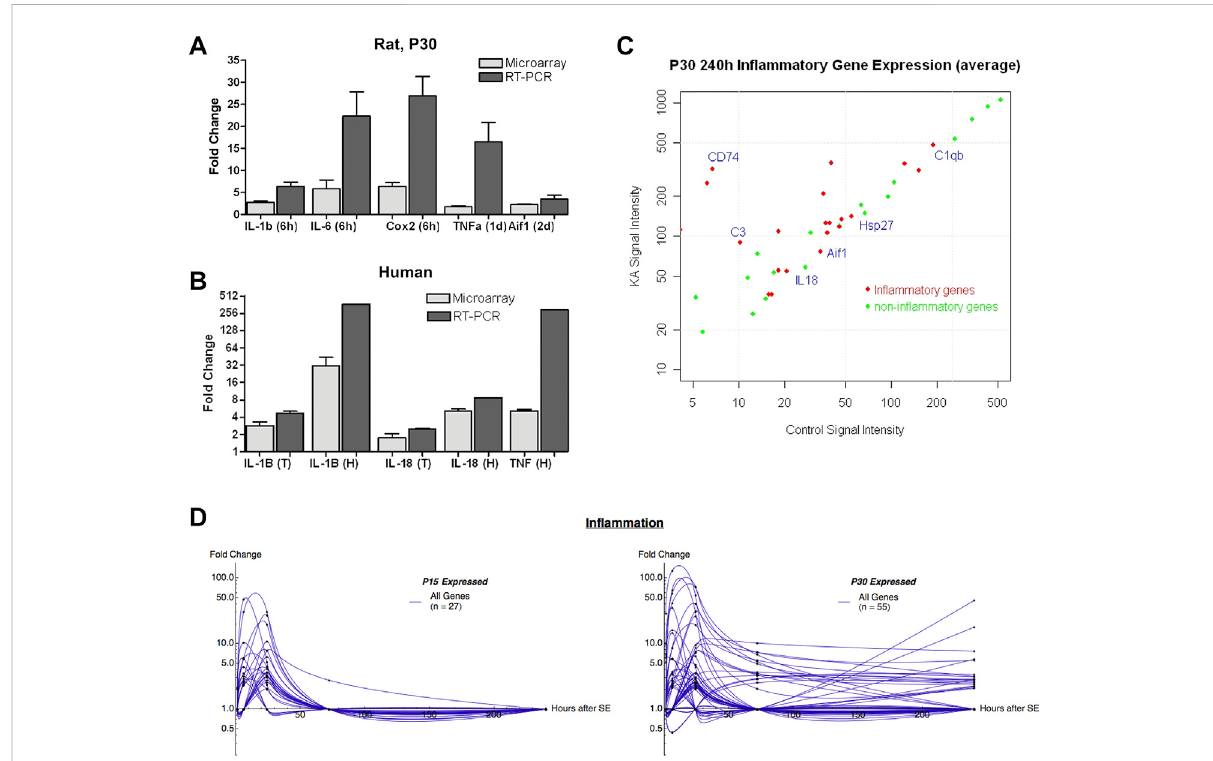
FIGURE 2 Time- and age-dependent expression of in fl ammatory genes after KA-SE: qRT-PCR validation and human data correlation. (A) Fold change in expression in select in fl ammatory genes: comparison between the microarray and qRT-PCR results in rats at P30. (B) Fold change in expression in select in fl ammatory genes: comparison between the microarray and quantitative RT-PCR results in human. T, temporal lobe; H, hippocampus. (C) In fl ammatory genes comprised a signi fi cant proportion of persistently upregulated genes at 240 h after KA-SE in P30. Red dots represent in fl ammatory genes. Green dots represent non-in fl ammatory genes. (D) Summary graph of the time course of fold change in in fl ammatory genes. Note the in fl ammatory genes remain signi fi cantly elevated at 240 h only in P30